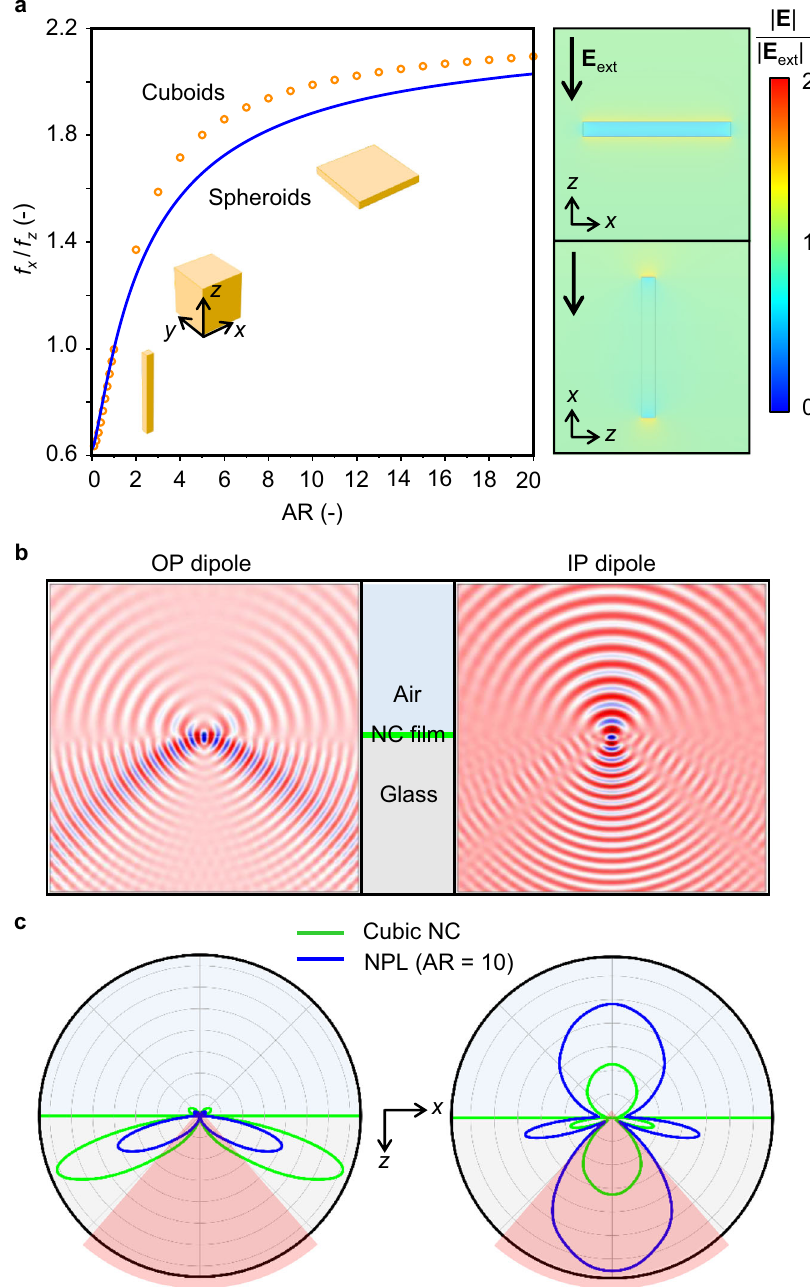
Fig. 1 Emission polarization in anisotropically dielectric-con fi ned NCs. a Calculated ratio of horizontal ( x ) to vertical ( z ) local fi eld factor, f x / f z , as a function of AR considering individual cuboidal and spheroidal perovskite NCs ( ϵ NC = 4.7) embedded in a low-dielectric-constant ligand ( ϵ m = 2.129) medium. Right panels present simulated electric fi eld distributions near a representative square ANC of AR = 10 by applying a constant vertical (top) and horizontal (bottom) external electric fi eld, E ext , revealing the polarization anisotropy. Calculated electric fi eld intensity pro fi les ( b ) and radiation patterns ( c ) in the x – z plane for an out-of-plane (OP; left) and in-plane (IP; right) dipole placed in the center of a cubic NC and ANC of AR = 10 embedded in a dielectric emissive fi lm sitting on the glass substrate. The dielectric anisotropy of ANC rescales the radiation from horizontal and vertical transition dipoles, thereby directing more light within the critical angle (red angular regions) for the glass-air interface ( x – y